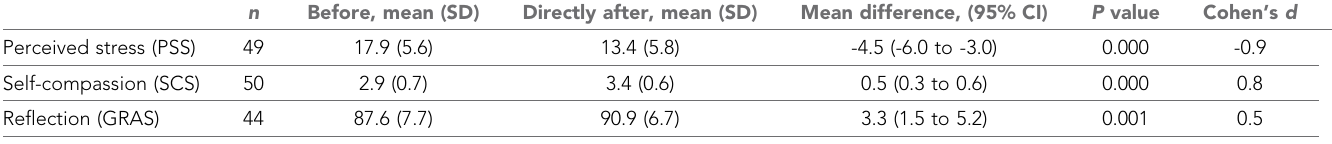
Table 2. Differences in perceived stress, reflection, and self-compassion between ’before’ and ’directly after’ the mindfulness training n